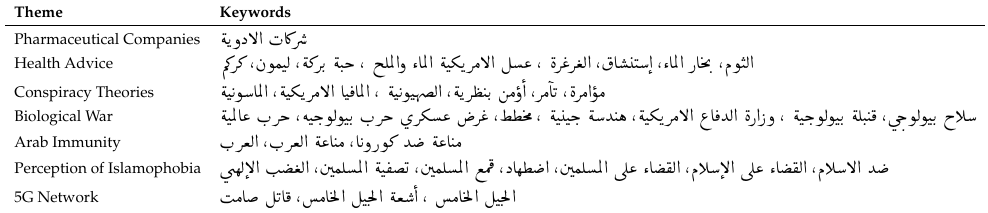
Table 2. Keywords used to retrieve relevant tweets.